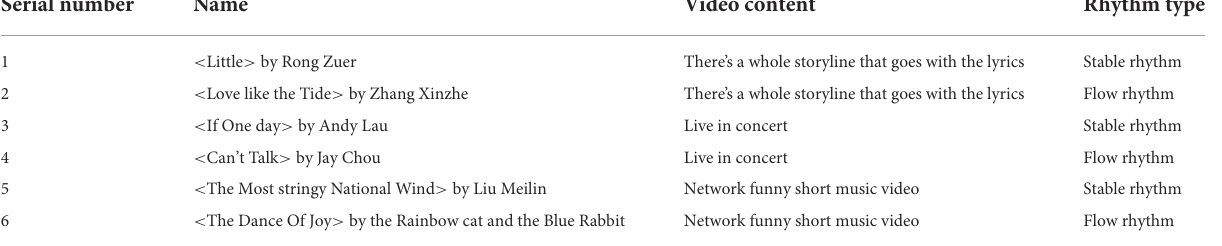
TABLE 2 Selection of short music video